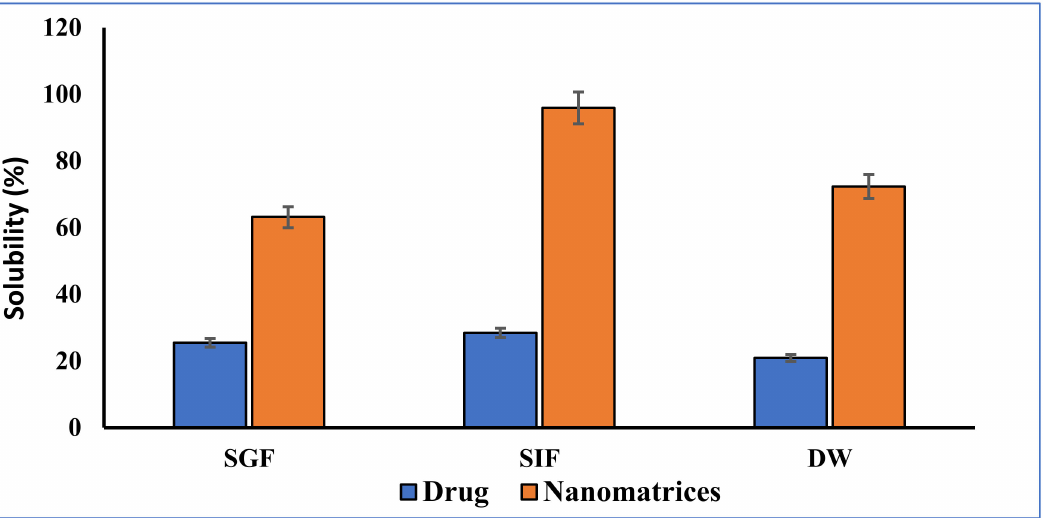
Figure 6. Percentage solubility study of pure drug SIM and drug in nanomatrices at SGF (pH 1.2), SIF (pH 6.8) and